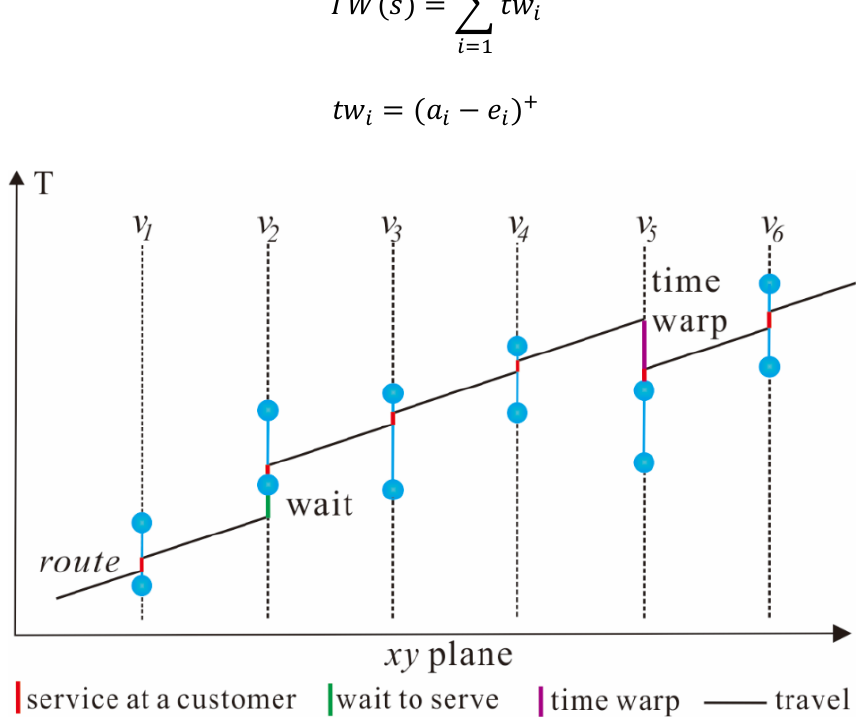
Figure 6. Wait time and time warp at a